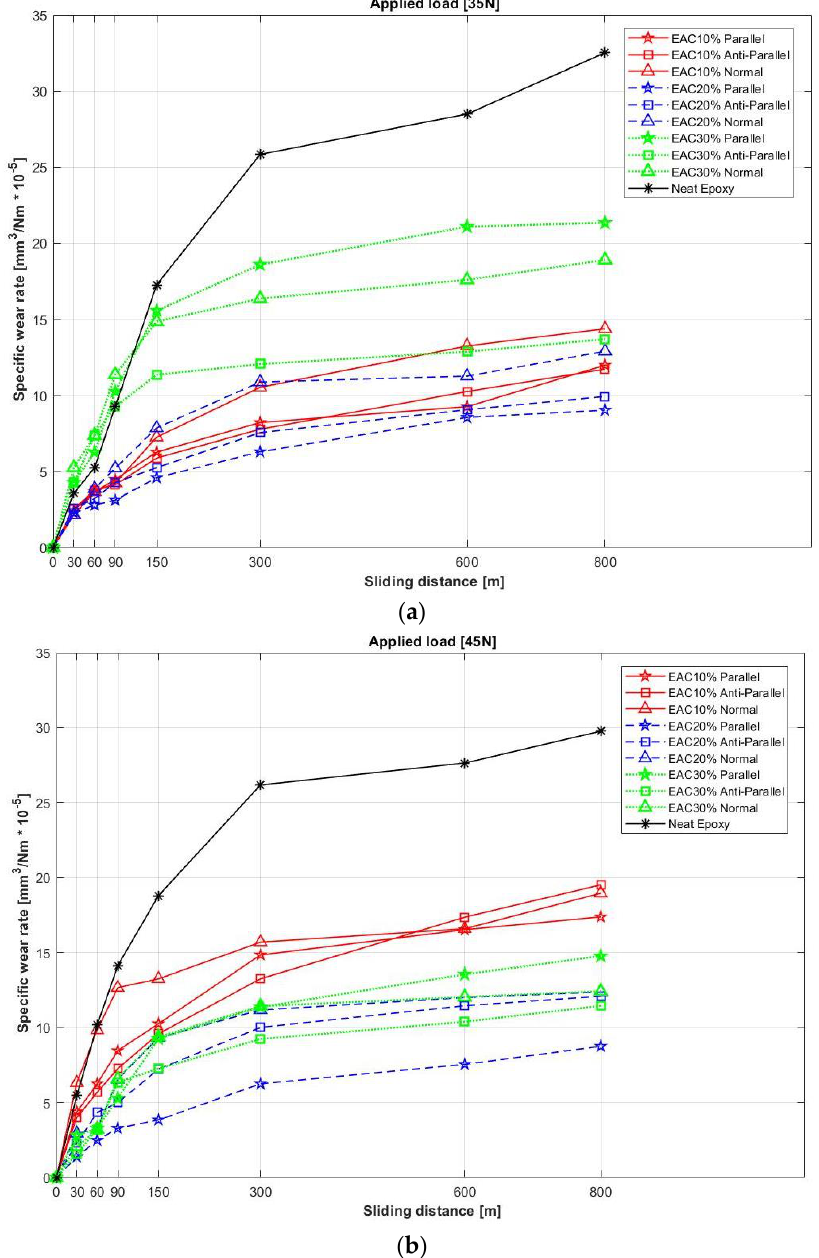
Figure 8. Specific wear rate of EACs and neat epoxy: ( a ) 35N applied load and ( b ) 45N applied load.